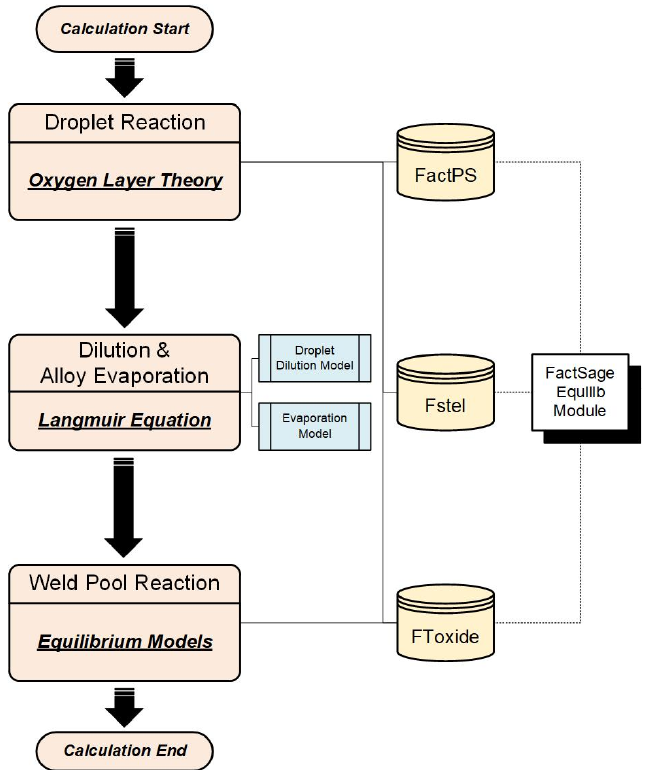
Figure 3. The process of modeling and the selection of thermodynamic databases.